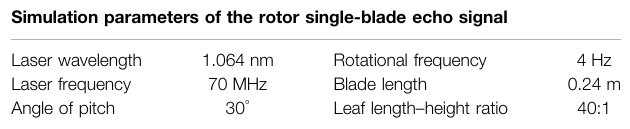
TABLE 1 | Echo signal simulation parameters of the rotor single